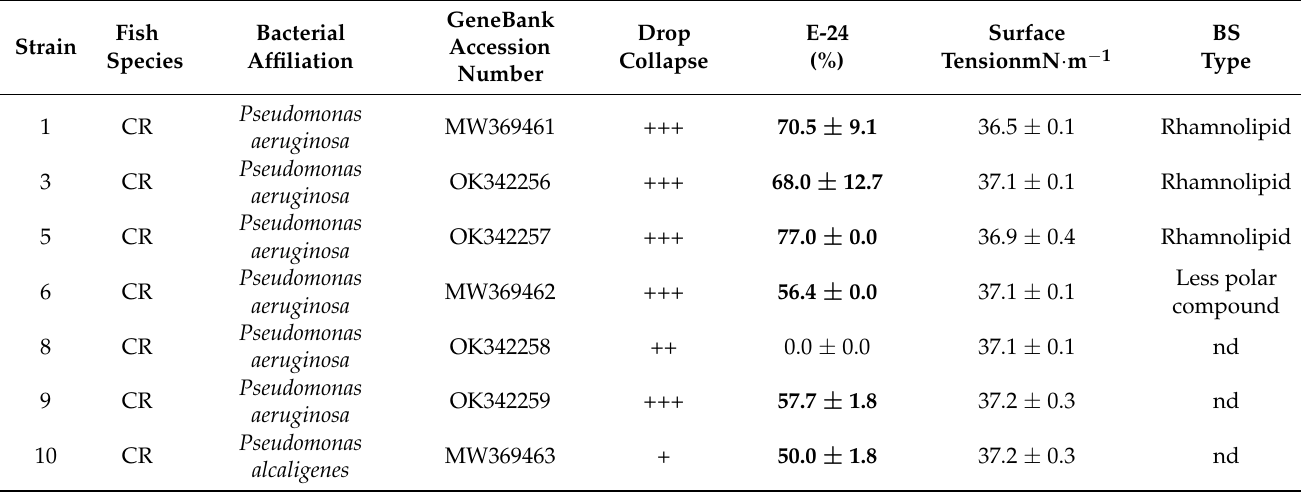
Table 1. BS-producing bacteria from grey mullets’ guts: bacterial affiliations (similarity 99–100%), performed tests: (mean ± SD) and TLC results. Highest E24 values are highlighted in bold.